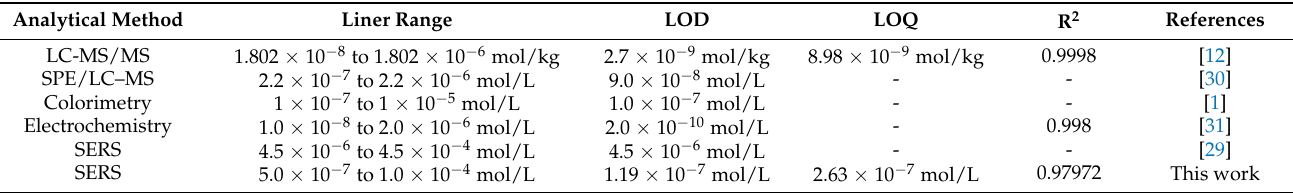
Table 1. Comparison of different methods for acetamiprid detection.